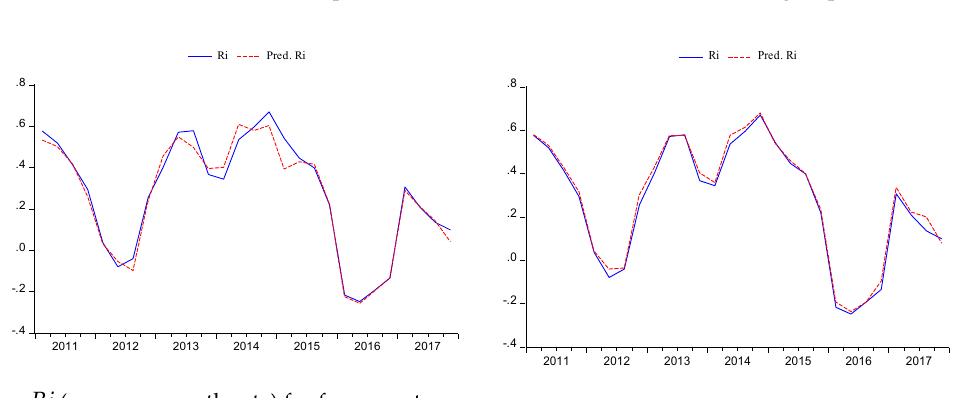
Figure 3. Actual and predicted trend graphs of BPNN model. Table 3. Regression results.